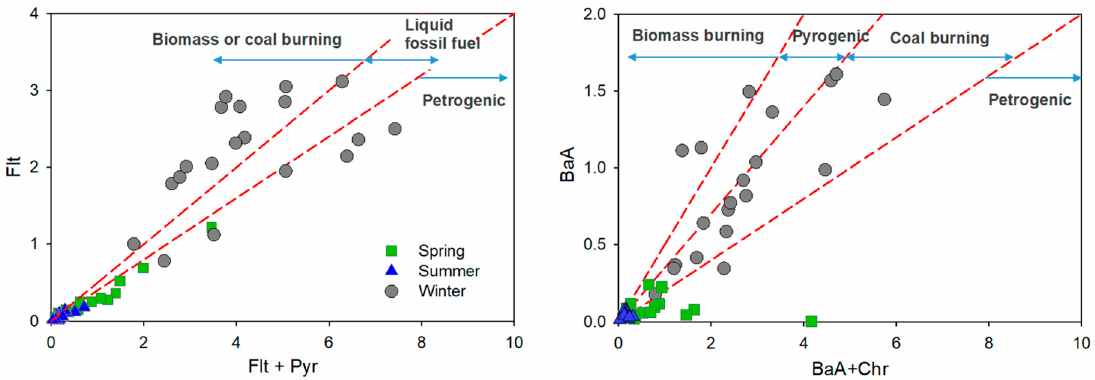
Figure 6. Diagnostic ratios to identify the major sources of PAHs.